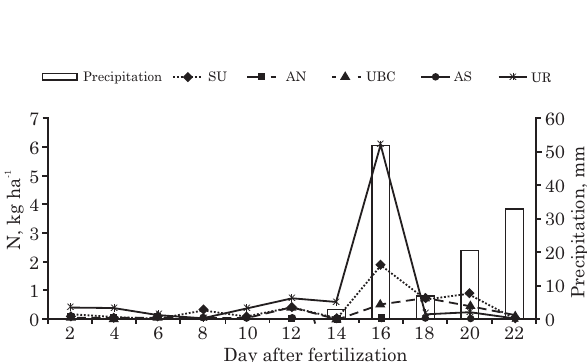
Figure 2. Daily precipitation and volatilization losses of NH 3 -N as a function of days after